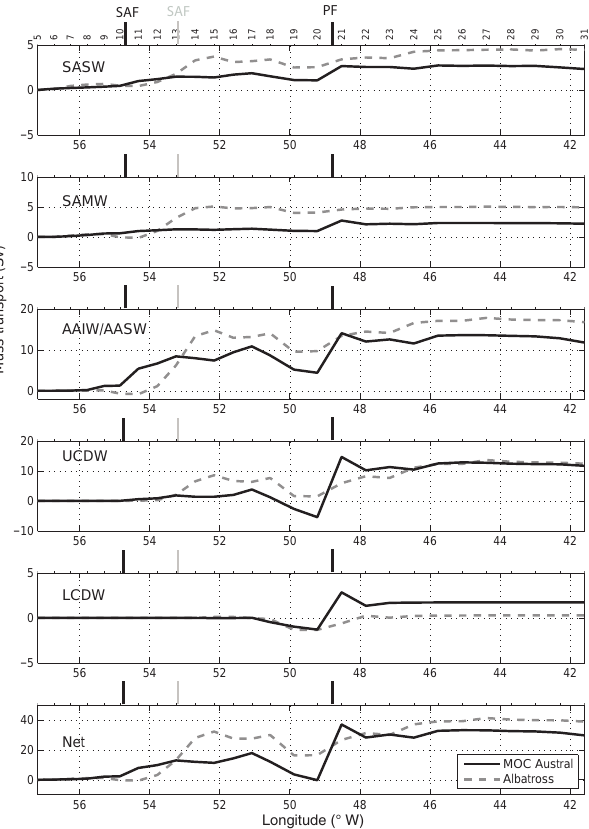
Figure 7. West-to-east accumulated relative geostrophic mass trans- port, computed across the ALBATROSS and MOC-Austral hydro- graphic sections. Station numbering and the front (SAF and PF) locations are displayed on the top axis. Note the different vertical